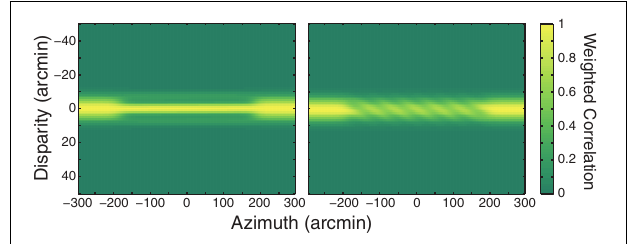
FIGURE 7 | Weighting function applied to cross-correlation output. A Gaussian ridge with a standard deviation of 4.5 arcmin was multiplied by the correlation outputs from Figure 1 . The ridge is centered on the fixation